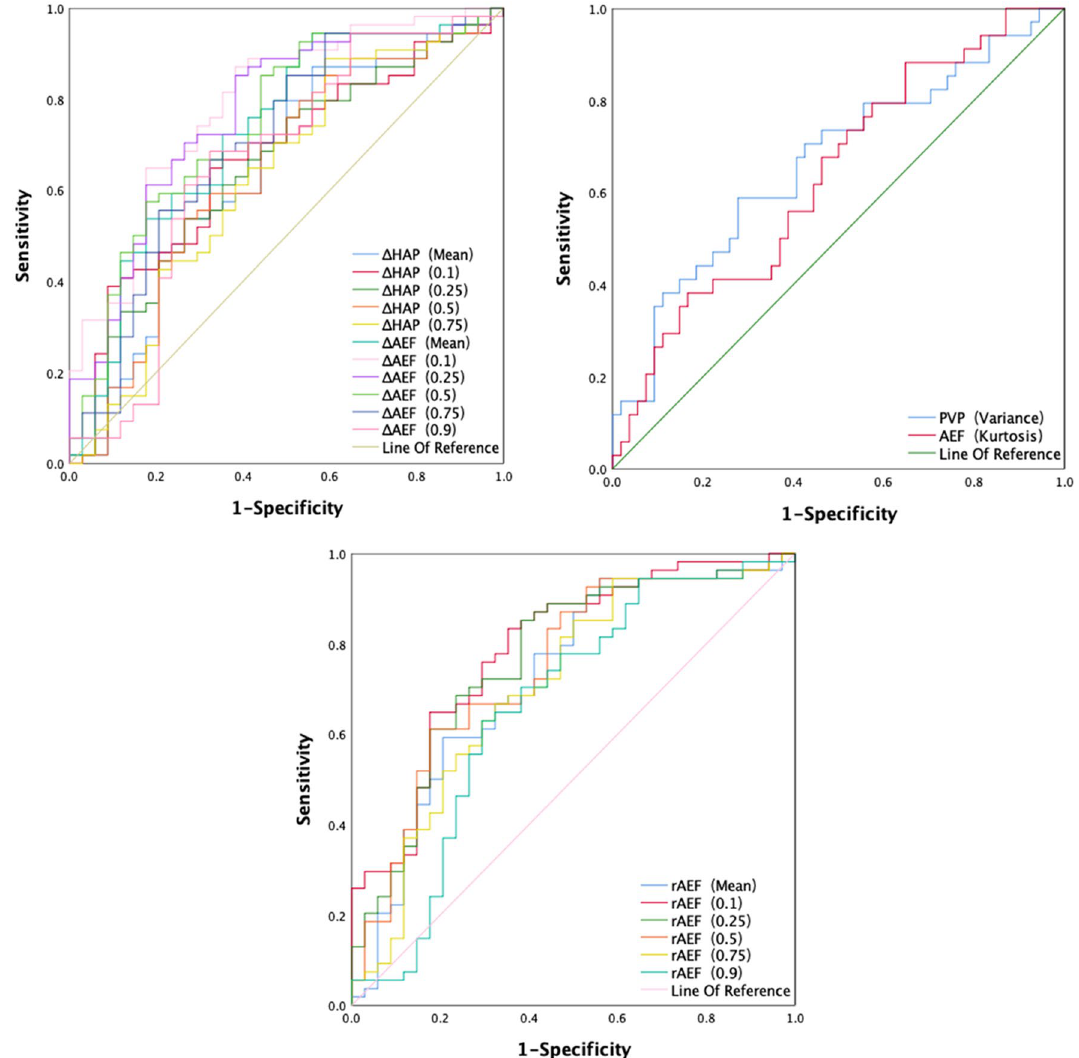
Figure 4. The ROC analysis of the ΔAEF, rAEF, ΔHAP, and the corresponding percentiles, PVP variance , AEF kurtosis for IMCC and HCC. ΔAEF Difference in arterial enhancement fraction (AEF tumor −AEF liver ), rAEF Relative arterial enhancement fraction (ΔAEF/AEF liver ), ΔHAP Difference in hepatic arterial perfusion (HAP tumor −HAP liver ), PVP variance The variance of the portal vein perfusion, AEF kurtosis The kurtosis value of the arterial enhancement fraction, ROC Receiver operating characteristic, IMCC Intrahepatic mass-forming cholangiocarcinoma, HCC Hepatocellular